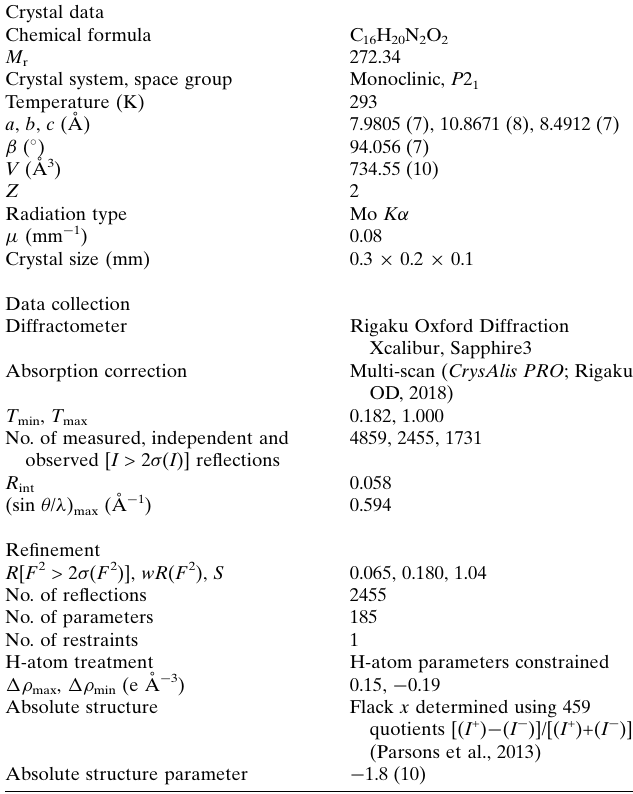
Table 3 Experimental details.